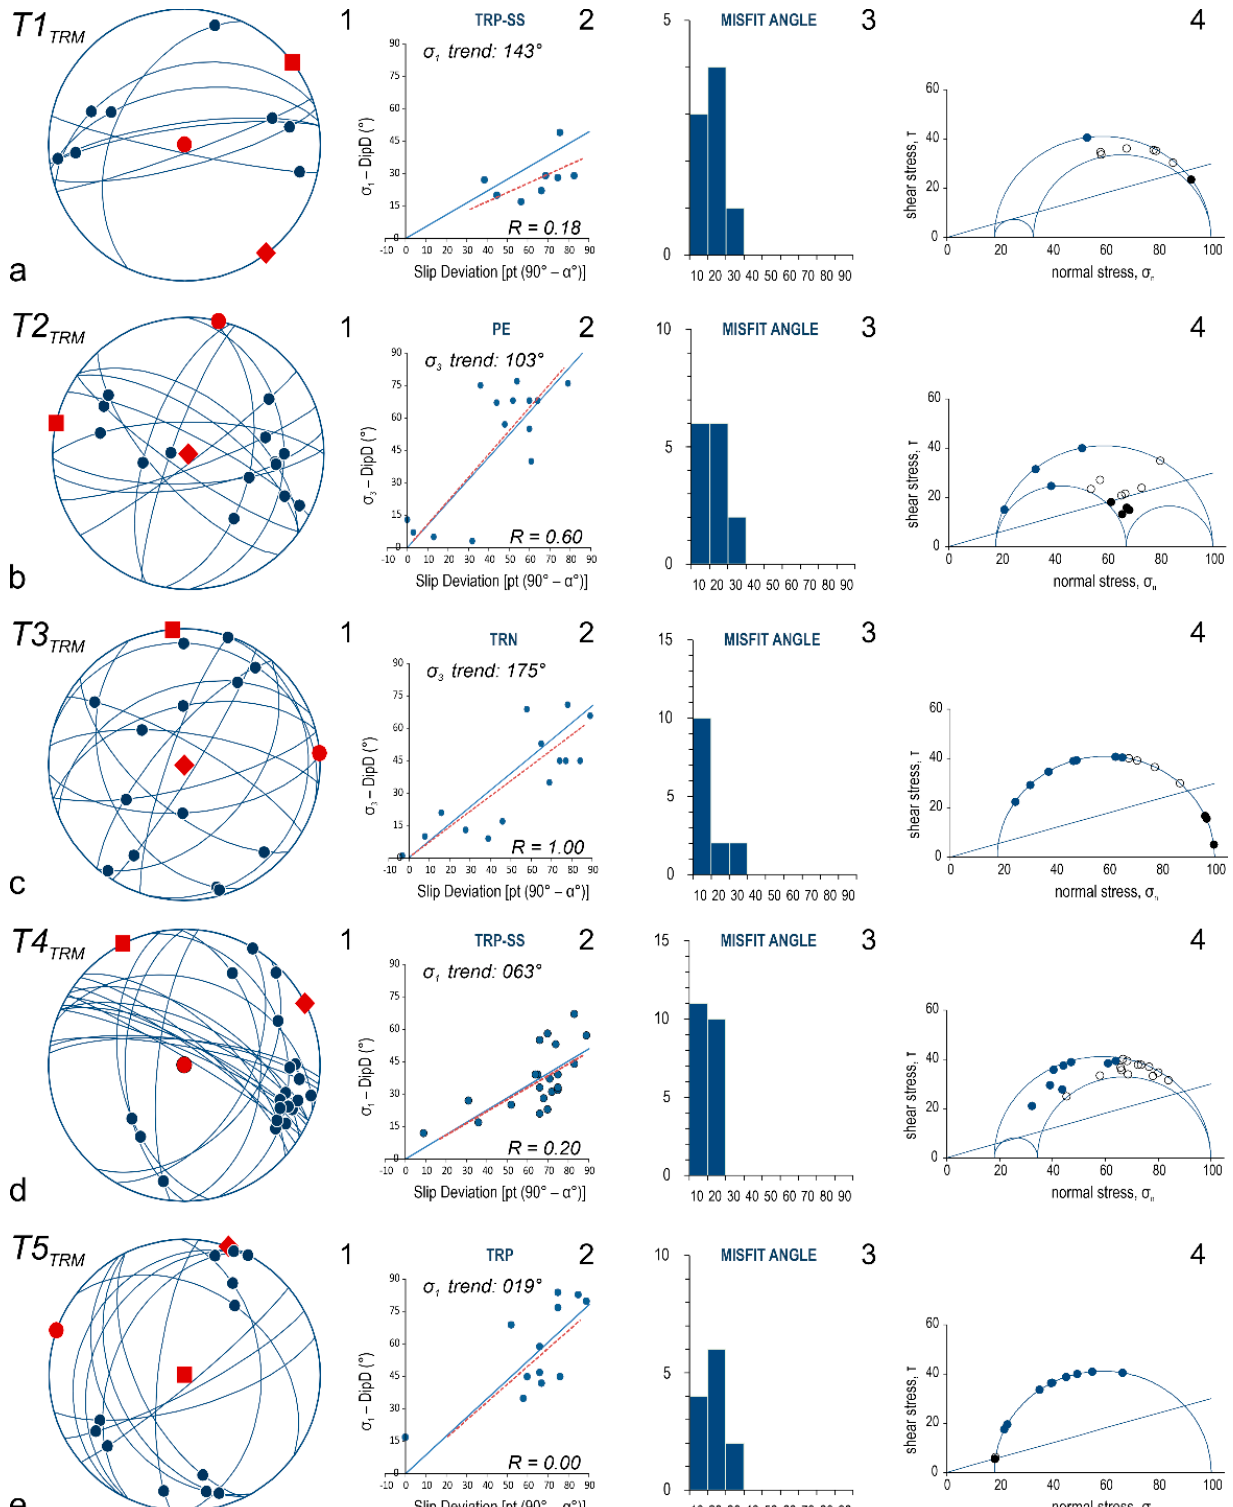
Figure 3. The TRM application [41] to the same fault-slip dataset as presented by [40]. The optimal resolved stress tensors ( σ 1 : solid rhomb, σ 2 : solid circle, and σ 3 : solid square) ( a ) T1 TRM , ( b ) T2 TRM , ( c ) T3 TRM , ( d ) T4 TRM , and ( e ) T5 TRM , from the whole fault-slip dataset and Misfit Angle (MA) ≤ 30°. Ex- planation as in Figure 2.